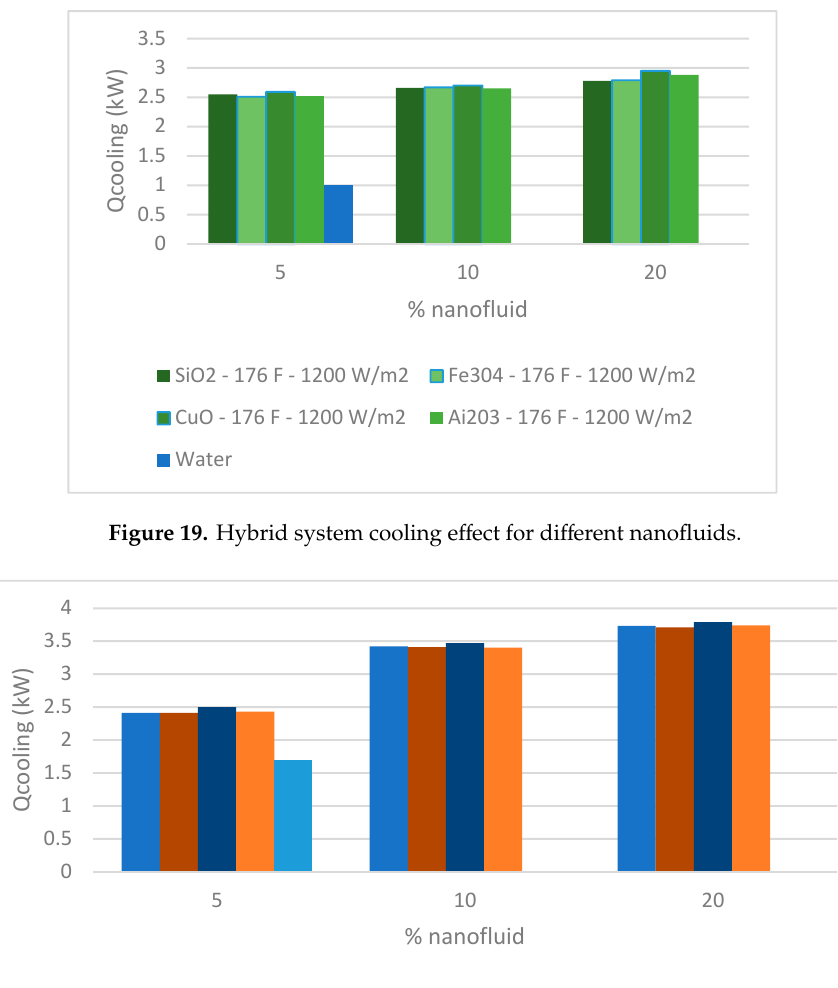
Figure 18. Hybrid system efficiency for different nanofluids at 212 °F